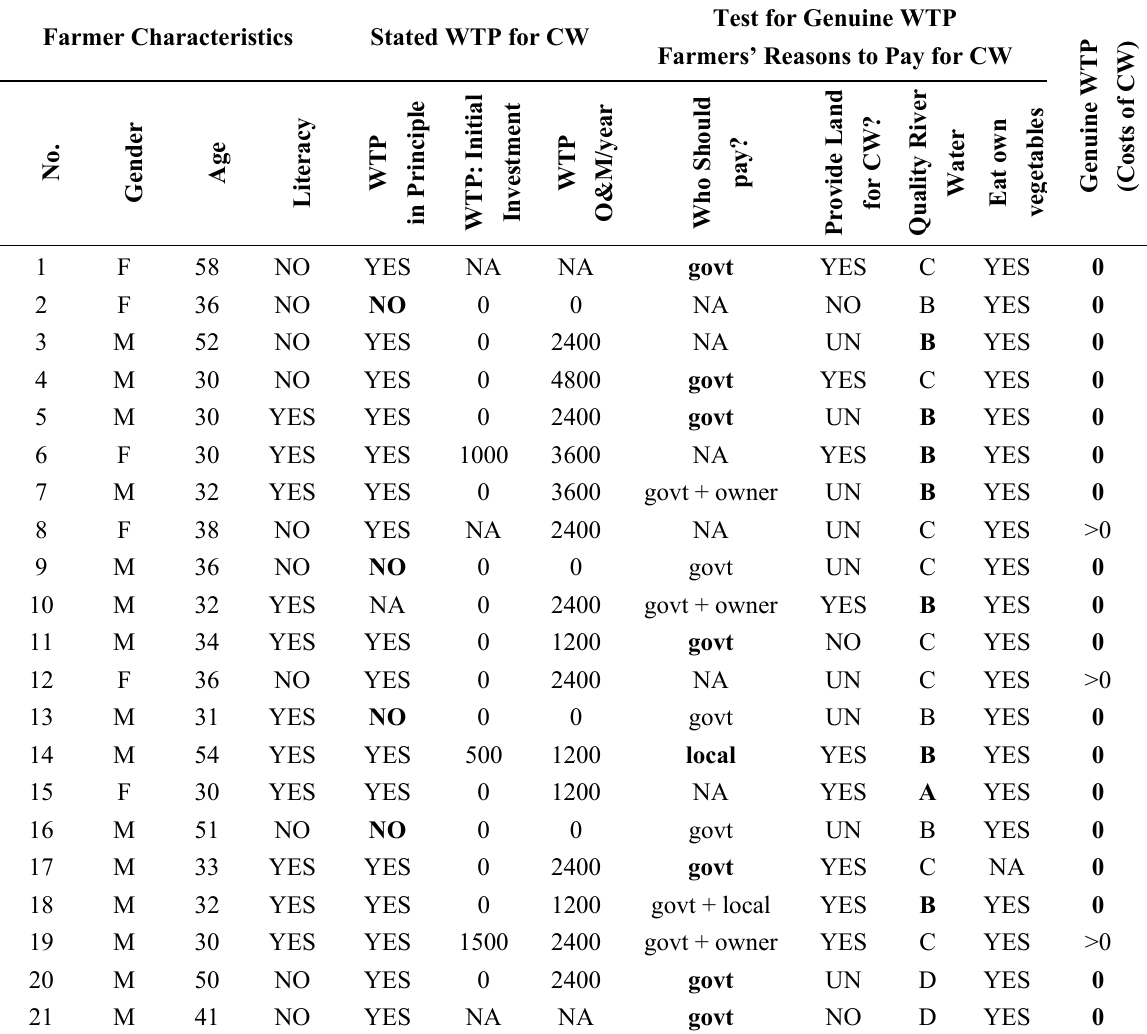
Table 6. Farmers’ genuine willingness to pay (GWTP) for treatment of river